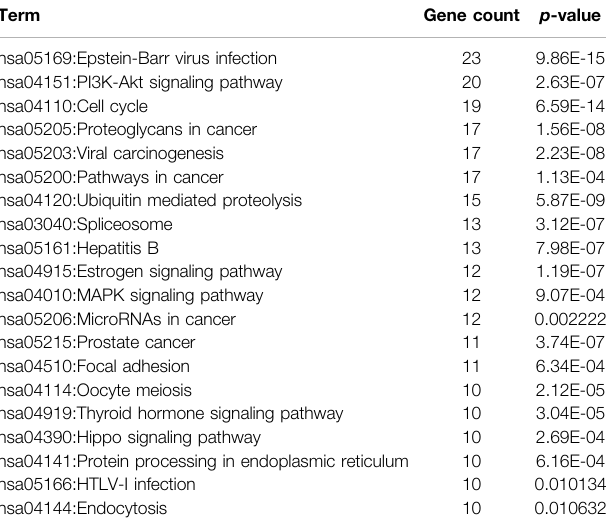
TABLE 3 | KEGG enrichment analysis of potential core targets for DSD against GC. Term Gene count p